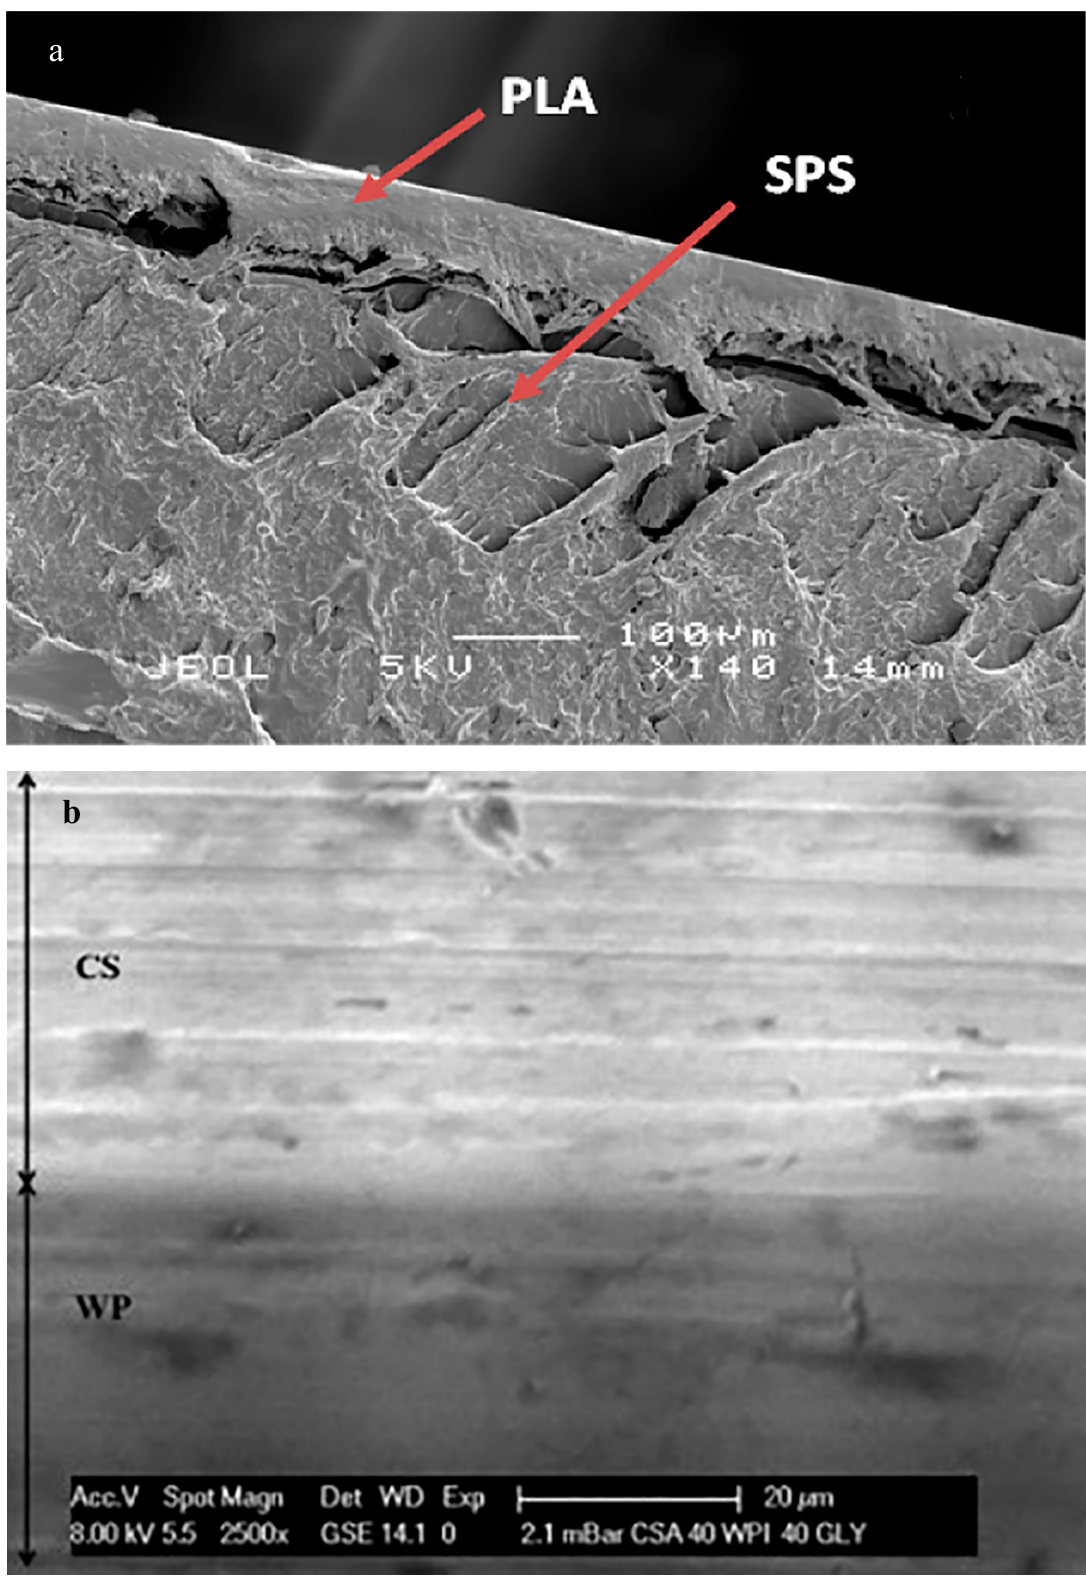
Figure 2. Scanning electron microscope (SEM) images of TD fracture surfaces of ( a ) PLA/sugar-palm starch (SPS) film [18] and ( b ) chitosan/whey protein (CS/WP) film [116] (reproduced with permission from Elsevier).